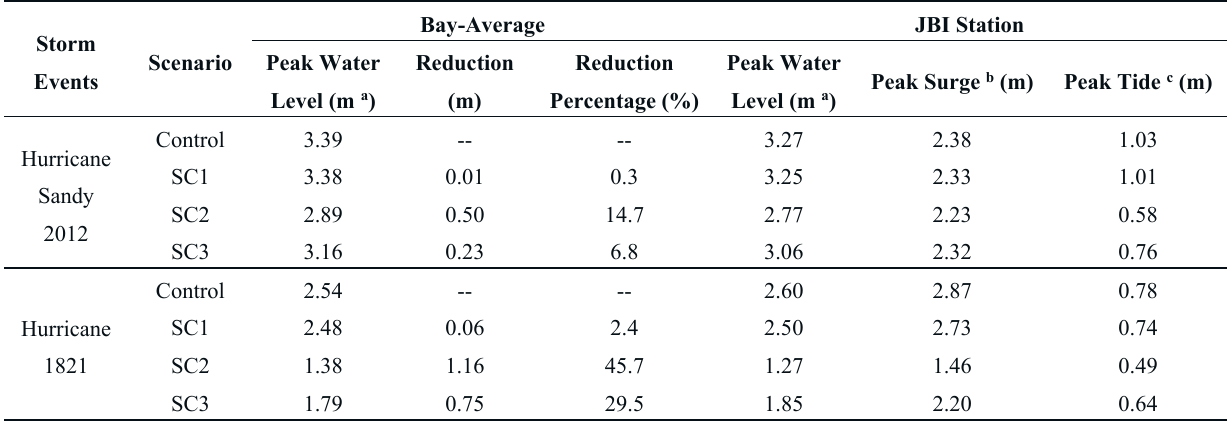
Table 1. Temporal maxima (peaks) and their reductions for each storm and scenario.